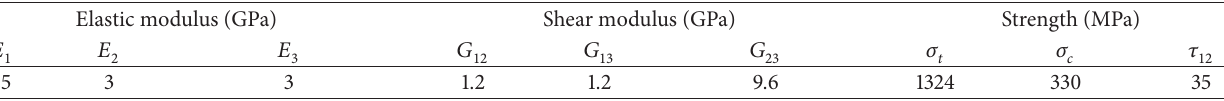
Table 1: Mechanical properties of glass fiber reinforced isophthalic unsaturated polyester resin composite tubes at 23 ∘ C and 50% relative humidity.